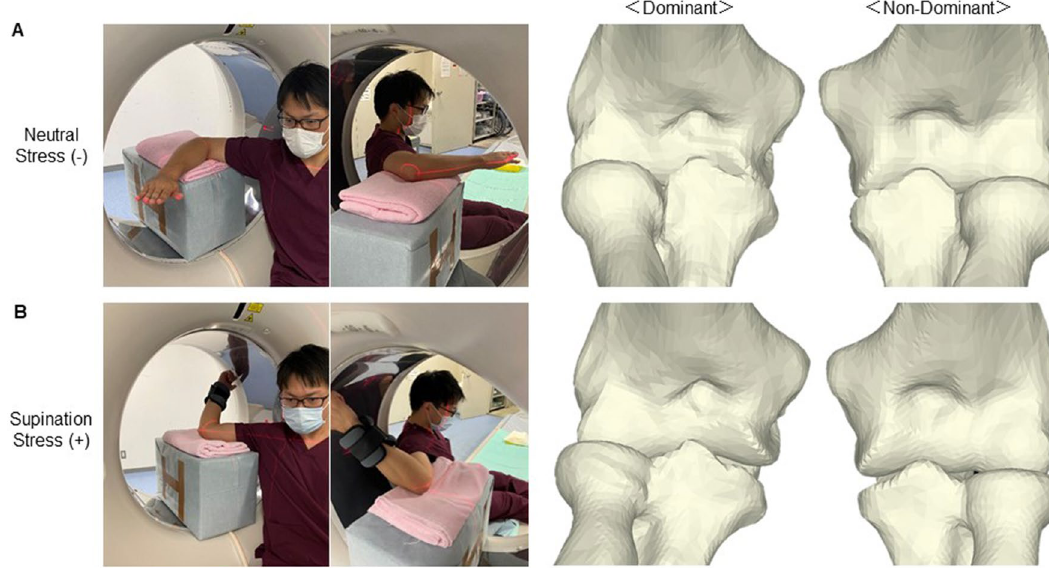
Figure 4. Acquisition of 3D bone models. ( A ) A CT image is obtained with the shoulder in abduction of 90° and the elbow flexed at 90° without valgus stress. 3D bone models of the humerus, radius, and ulna surfaces are created from each arm position. ( B ) With elbow valgus